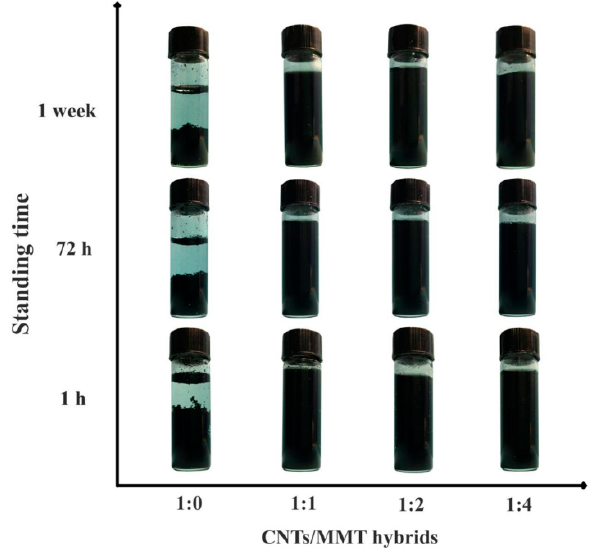
Figure 2. CNTs/MMT suspensions with various ratios.